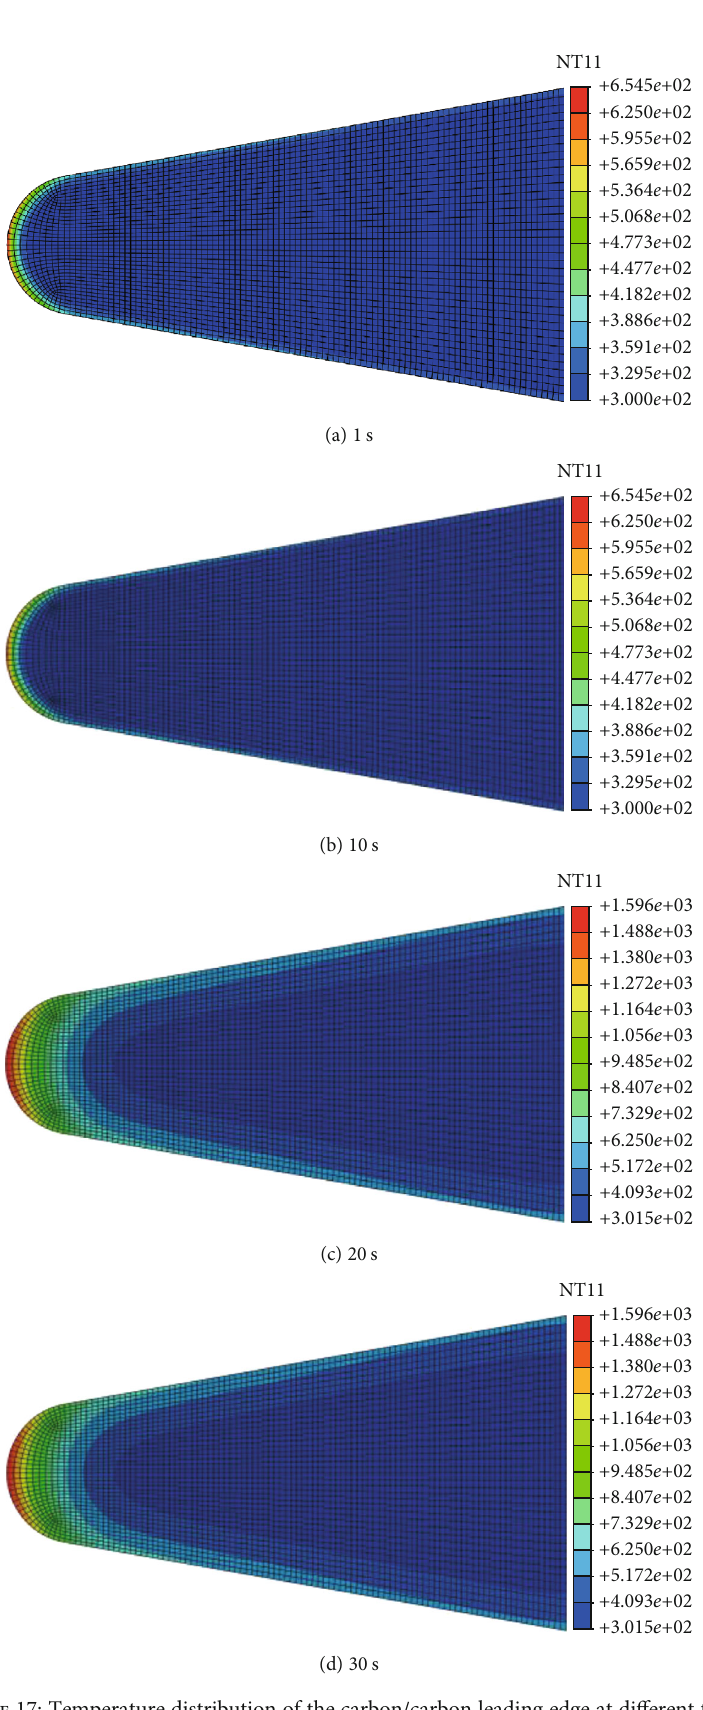
Figure 17: Temperature distribution of the carbon/carbon leading edge at di ff erent